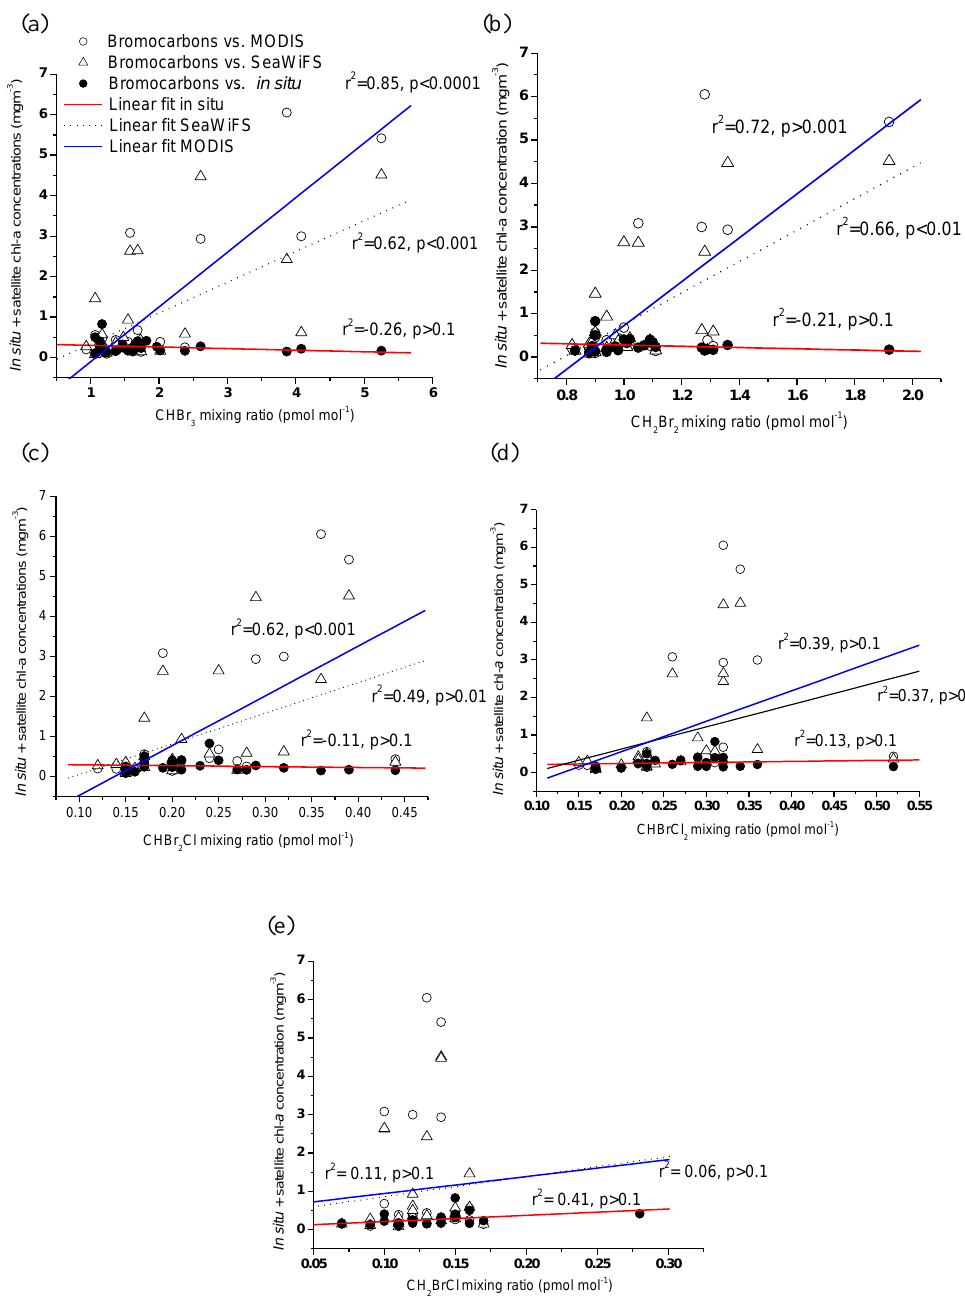
Figure 5. Monthly June–July 2009 in situ and satellite chl a concentrations as a function of VSLS bromocarbon mixing ratios: (a) CHBr 3 , (b) CH 2 Br 2 , (c) CHBr 2 Cl, (d) CHBrCl 2 , and (e) CH 2 Figure 5: Monthly June-July 2009 in situ and satellite chl- a concentration as a function of VSLS bromocarbons mixing ratios a) CHBr CH BrCl. 2